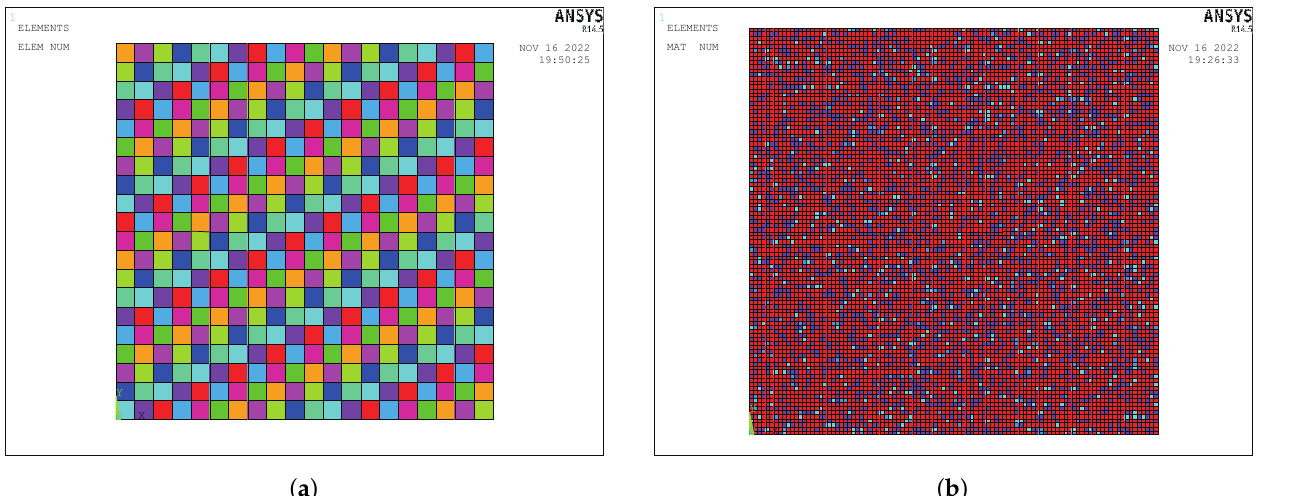
Figure 7. Finite element model of heat conduction unit in the GCIB: ( a ) 400 element model; ( b ) 10,000 element